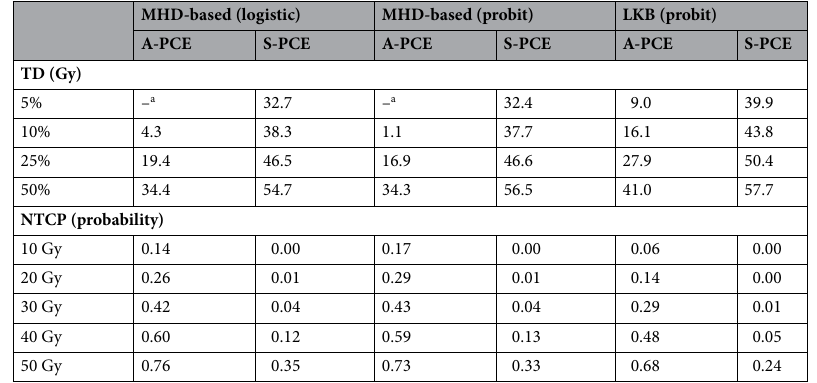
Table 3. Summary of the estimated TD and normal tissue complication probability stratified to the applied model and the grade of pericardial effusion. The upper row presents estimated TD 5 , 10 , 25 and TD 50 according to the calculated model and grade of PCE. The bottom row presents the NTCP for each 10 Gy. Regarding the LKB model, 10 Gy means gEUD whereas for the MHD-based model, 10 Gy means MHD. a TD 5 for the MHD-based model was not achieved because it was outside the fitting curve. A-PCE: pericardial effusion in any grade; gEUD: generalised equivalent uniform dose; LKB: Lyman–Kutcher–Burman; MHD: mean heart dose; MPD-based: mean pericardial dose-based; NTCP: normal tissue complication probability; S-PCE: symptomatic pericardial effusion; TD: TD 50 is the dose that corresponds to a 50% risk of complications when the whole organ is